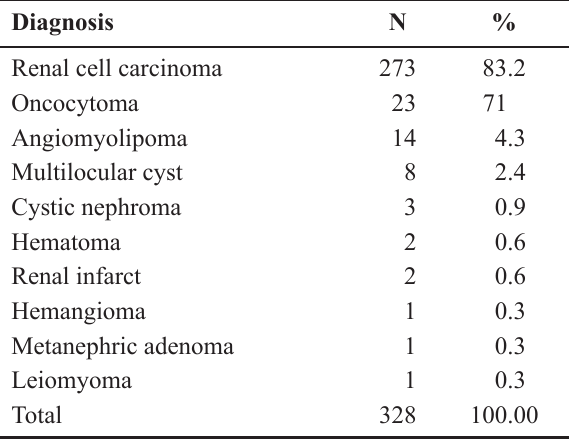
Table 1 – Pathological findings in 328 renal